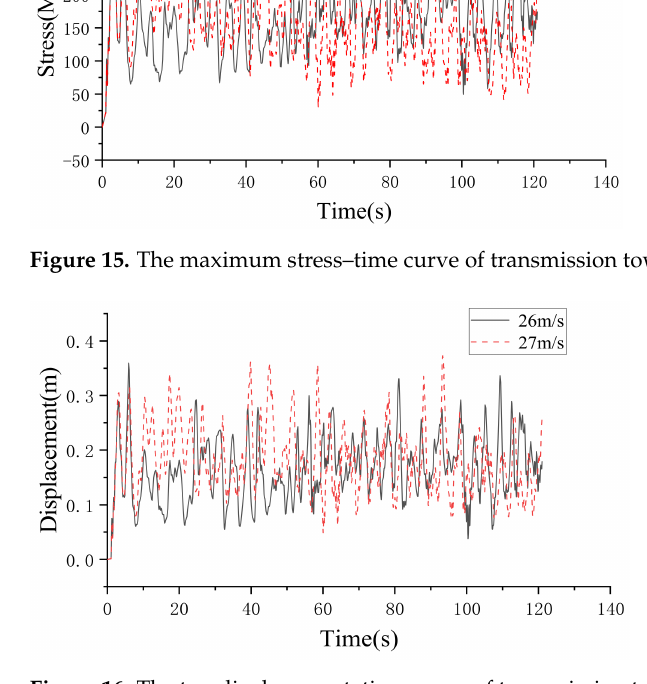
Figure 16. The top displacement–time curve of transmission